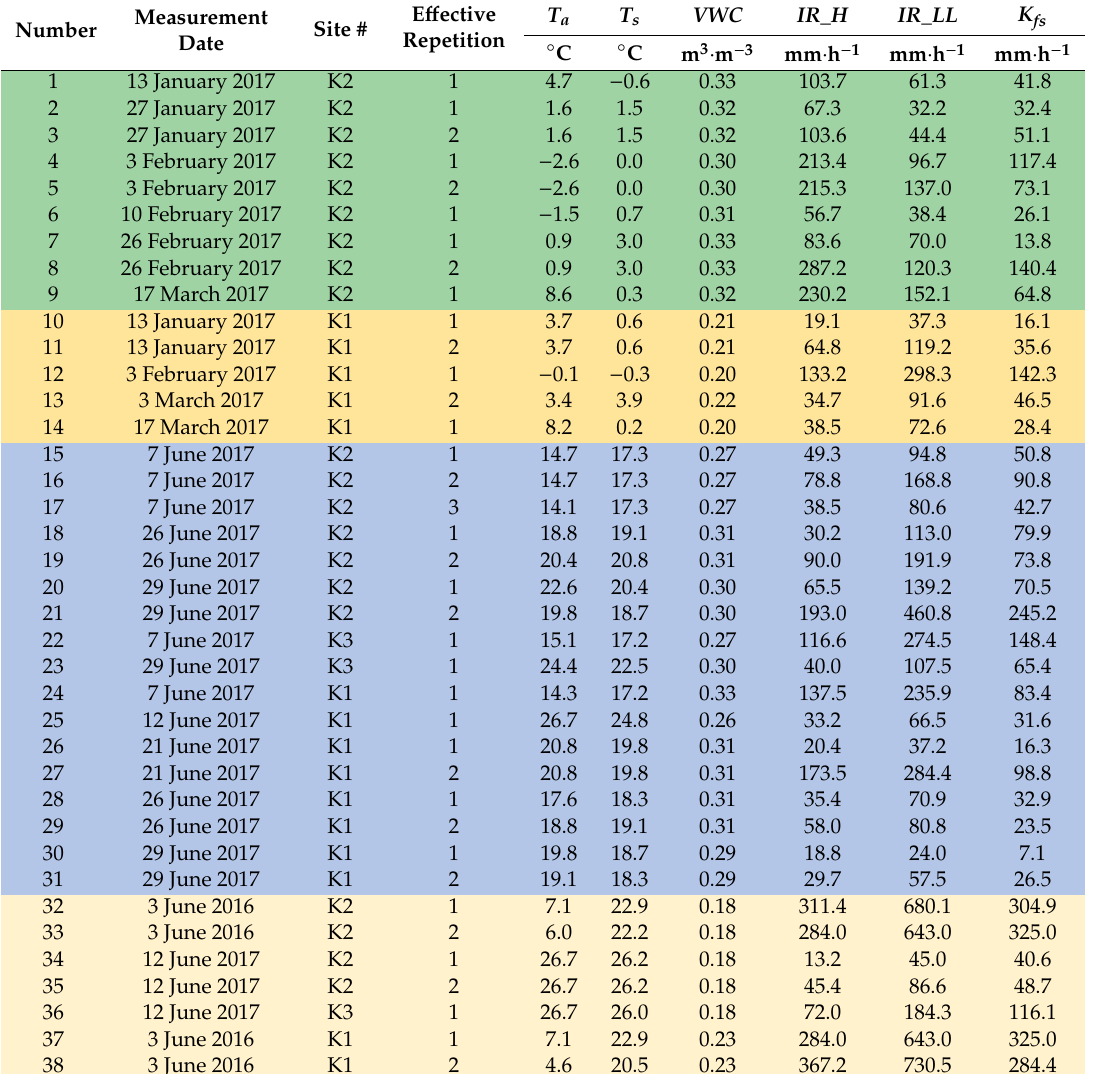
Table 3. Date, site, air temperature ( T a ), soil temperature ( T s ), antecedent soil volumetric water content (VWC), infiltration rates at the higher and lower pressure head ( IR_H and IR_L , respectively), and field-saturated soil hydraulic conductivity ( K fs ) of measurements using the optimized parameters defined in Table 2. Corresponding raw infiltration data are graphically presented in Figure 5, and di ff erent backgrounds from top to bottom in this table correspond to Figure 5a–d,